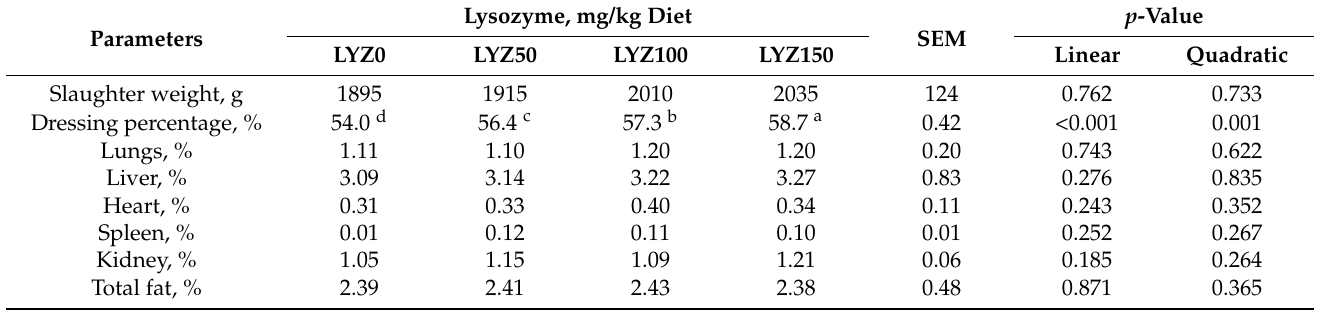
Table 4. Carcass characteristics in growing rabbits fed diets supplemented with different levels of lysozyme at 72 days of